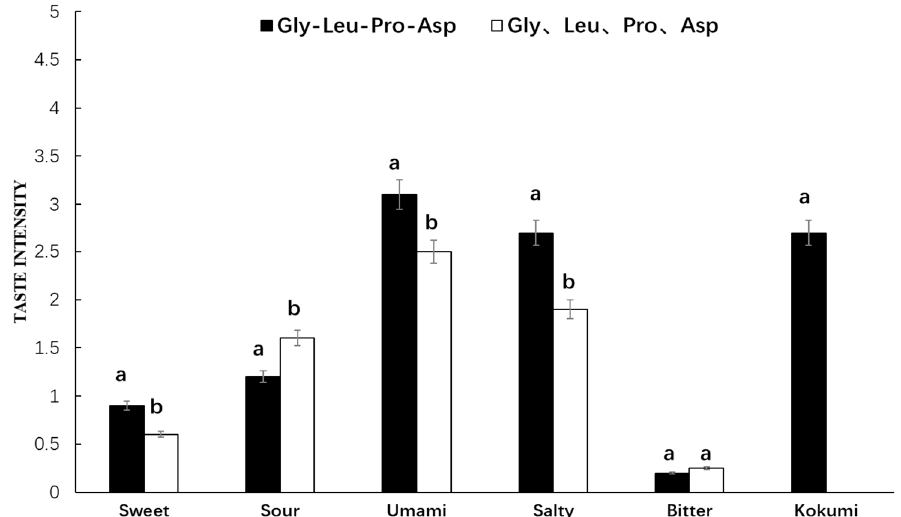
Figure 5. Sensory evaluation of peptide Gly-Leu-Pro-Asp and its mass-equivalent amino acids mixture in chicken broth. a, b The different letters in the same group represent that there are significant differences at the level of p < 0.05, and the same letters represent no significant difference.